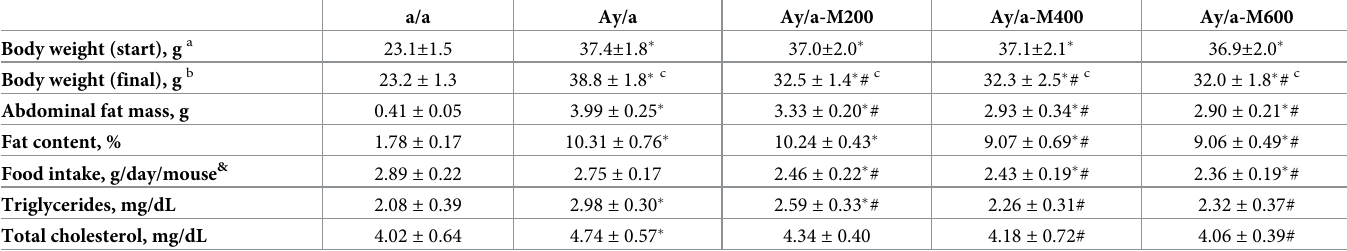
Table 1. The body and fat weight, food intake and lipids in the obese agouti-mice and the effect of metformin treatment.